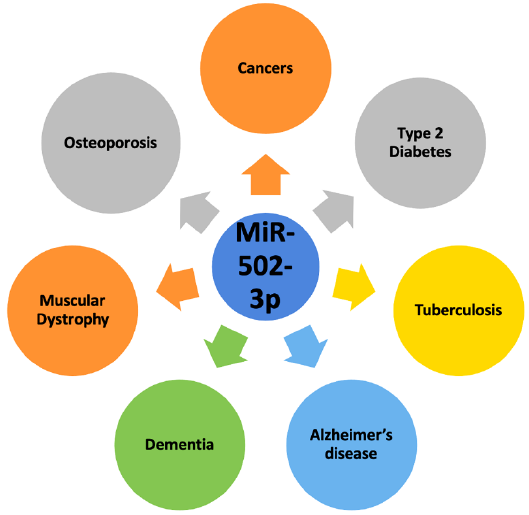
Figure 2. Involvement of miR-502-3p in most common human diseases. MiR-502-3p is involved in cancers,